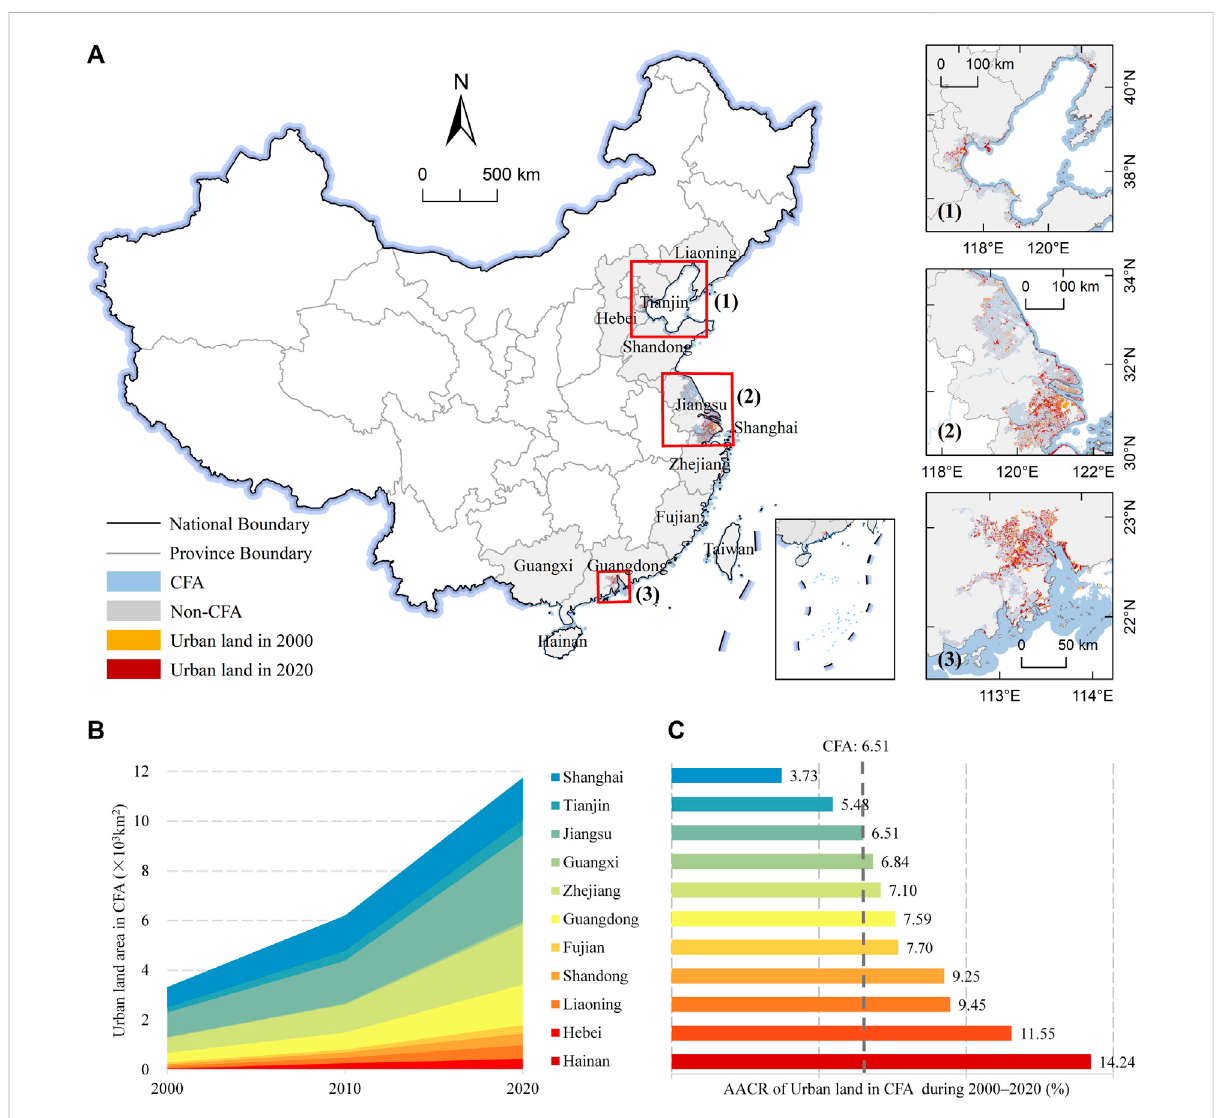
FIGURE 2 Changes of urban lands in CFAs of China during 2000 – 2020: the pattern (A) , growth amount (B) , and average annual change rates (C) .